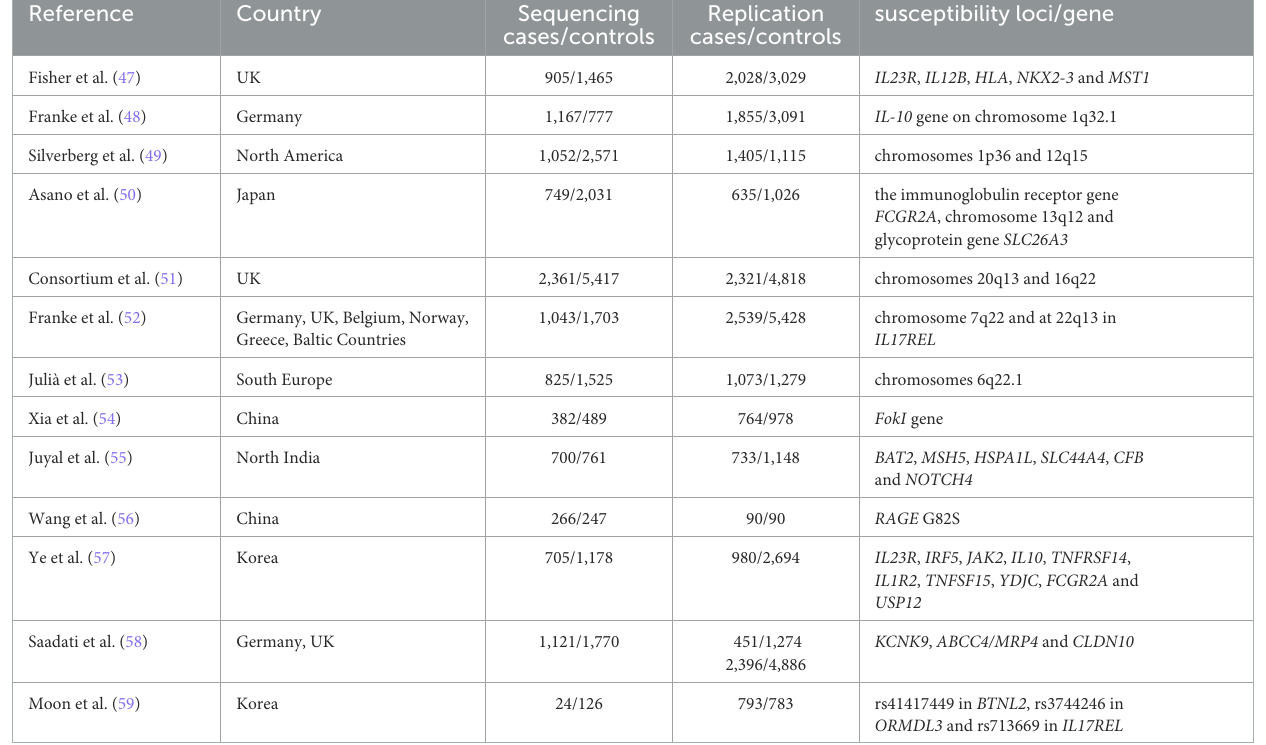
TABLE 6 Susceptibility to loci/gene for